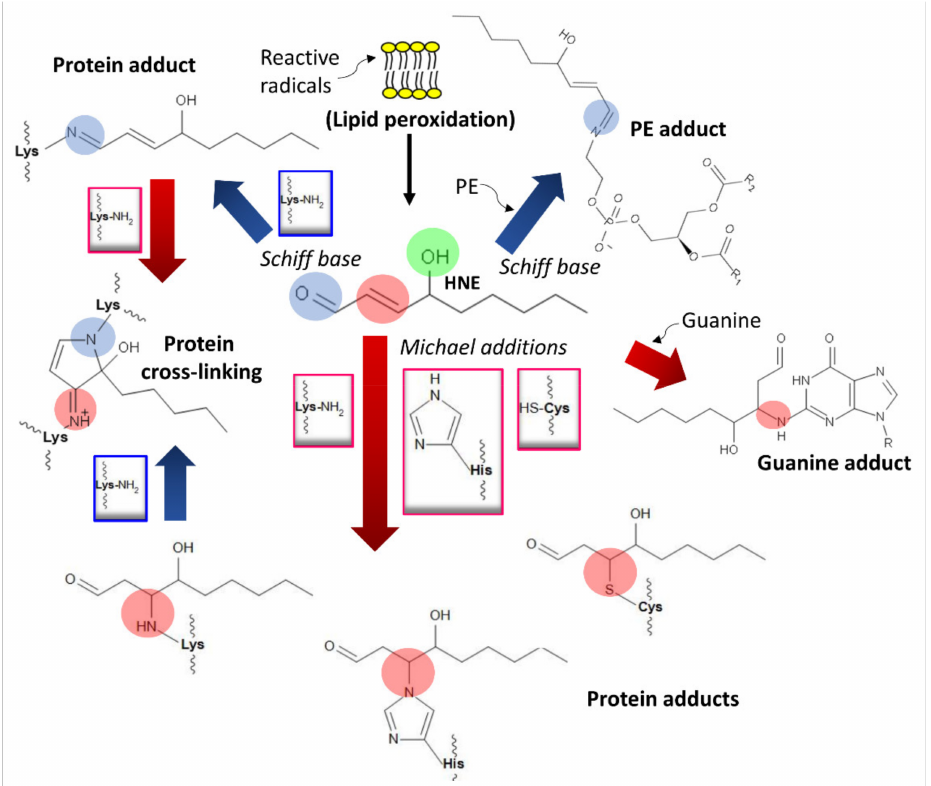
Figure 7. Protein adducts are generated by the reaction of amino, imidazole, and thiol groups of amino acids with reactive carbons of 4-hydroxy-2-trans-nonenal (HNE) through Schiff base formation or Michael additions to the C2=C3 double bond. HNE may react with lipids and DNA to generate adducts. Additional secondary reactions may occur between the carbonyl and the hydroxyl groups. Colored circles represent reactive groups within HNE that undergo different redox reactions. PE, phosphatidylethanolamine